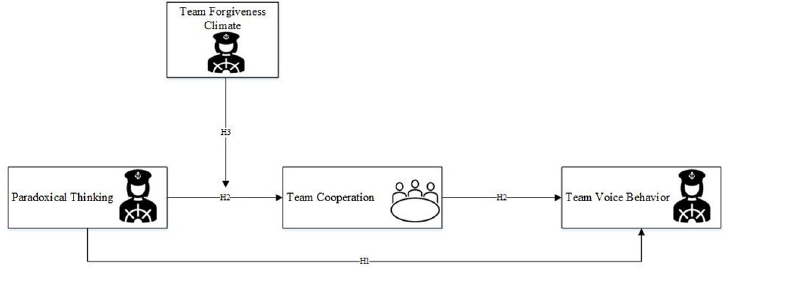
Fig 1. Research hypothesized model. Note: team member: leader: .